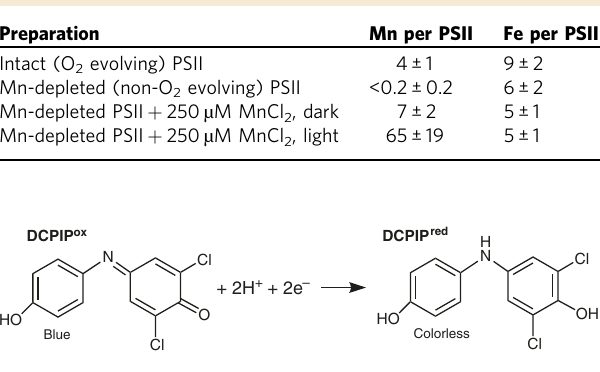
Fig. 2 Redox reaction associated with a color change of DCPIP (2,6- dichlorophenol-indophenol). The color of the oxidized molecule (DCPIP ox , left) is blue; the reduced molecule (DCPIP red , right) is colorless.